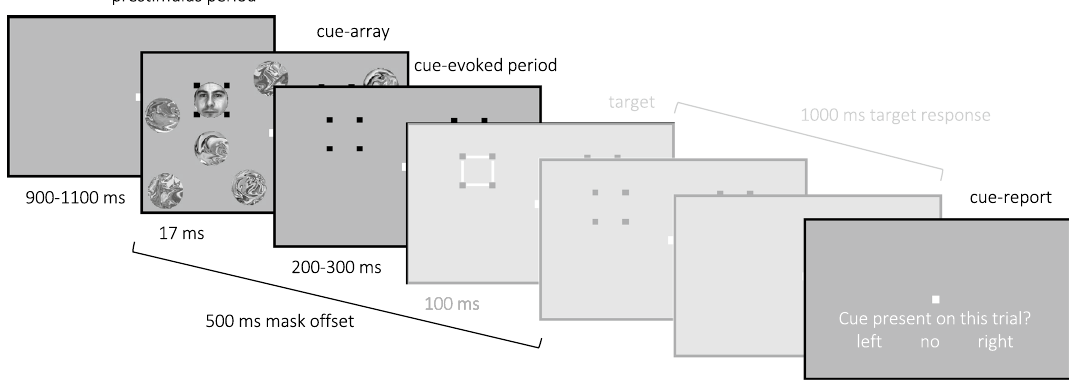
Figure 1. A sample trial sequence. After a jittered prestimulus fixation period, a transient cue-array appeared, which contained distractors and two potential cue-locations that were each denoted with a four-dot OSM mask. On 80% of trials, a cue appeared within one of the cue-locations. In 70% of trials, a target then appeared at one of the cue-locations after a jittered ISI (note that the target sequences and responses were not investigated in the current work and are thus greyed out in this illustration). On every trial, the mask-offset and the time allocated for target response was fixed. At the end of each trial, participants reported the location of the cue or indicated that the cue was absent. Cue-perceived trials were operationalized as trials when the participant correctly discriminated the location of the cue, and not-perceived trials were operationalized as trials when the participants incorrectly indicated that the cue was absent. This figure was adapted from Figure 1 of Giattino et al. 48 and is not drawn to